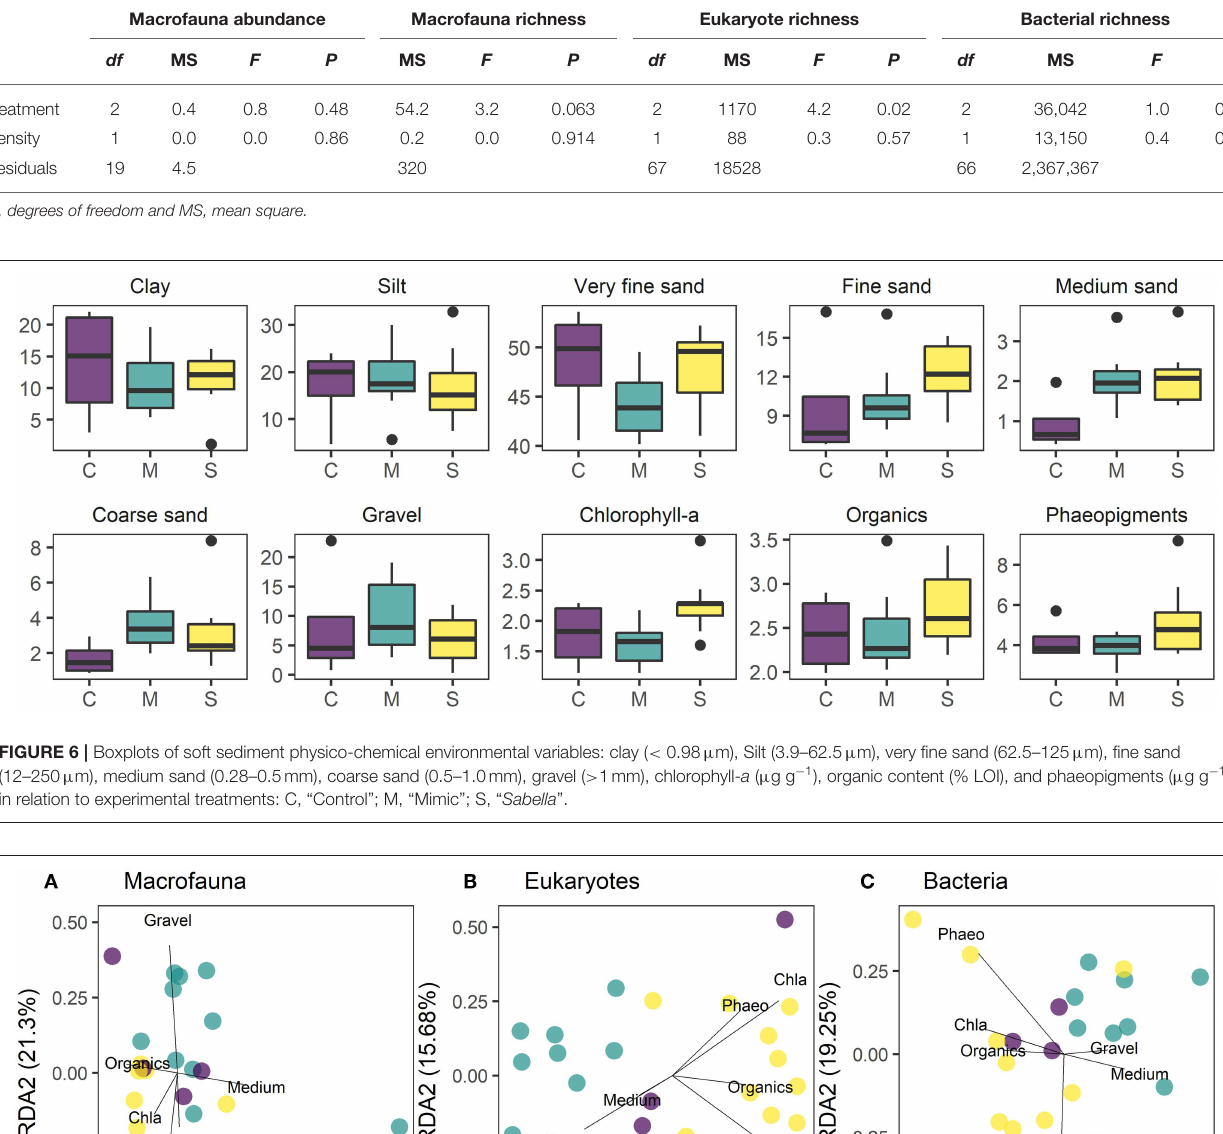
TABLE 2 | Results of univariate analyses of covariance (ANCOVAs) to test the effect of Treatment (“ Sabella ,” “Mimic” and “Control”) and Sabella spallanzanii Density on macrofaunal, eukaryote, and bacterial univariate indices. Macrofauna abundance Macrofauna richness Eukaryote richness Bacterial richness